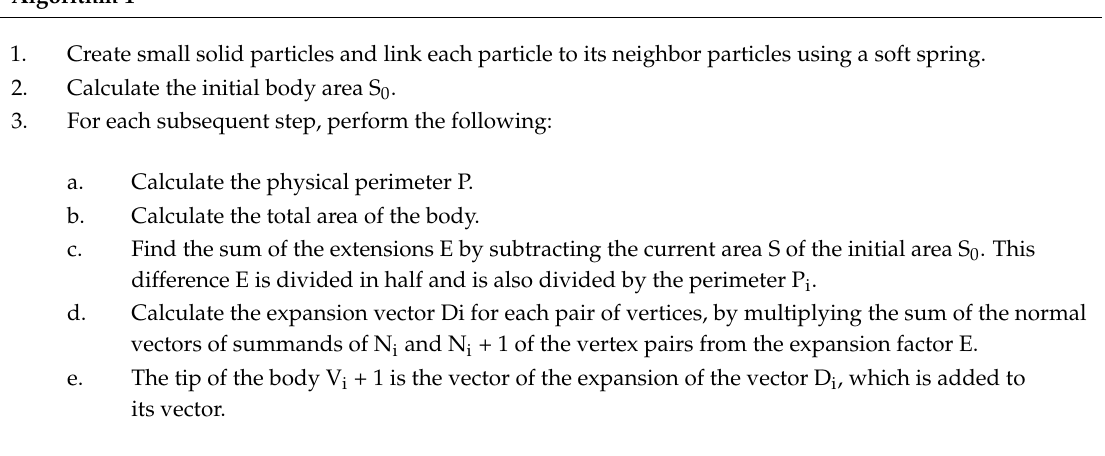
Figure 3. An example of a deformed polygon-shaped body and a circle-shaped body.